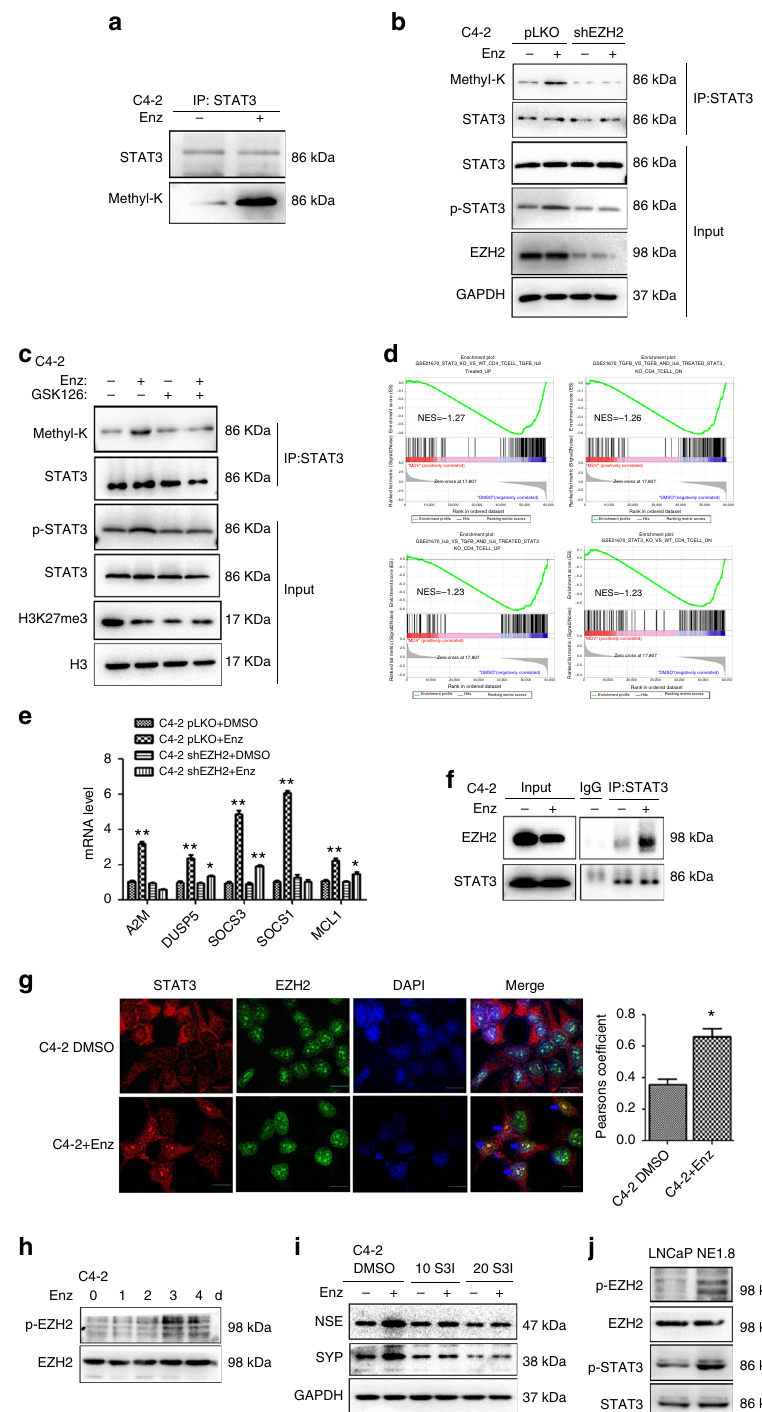
Fig. 4 EZH2 methylates STAT3 to promote NED after Enz treatment. a STAT3 methylation (Methyl-K) is increased in C4-2 cells treated with/without (w/o) 10 μ M Enz for 4 days and the lysine methylation of STAT3 detected by anti-lysine methylation antibody. b EZH2 knockdown can reduce Enz increased STAT3 methylation. C4-2 pLKO vector and shEZH2 cells were treated w/o Enz for 5 days, and then STAT3 methylation and phosphorylation detected by WB. c EZH2 inhibitor can reduce Enz-Increased STAT3 methylation. The levels of STAT3 methylation and phosphorylation w/o Enz and GSK126 treatment were detected by WB. d GSEA of STAT3 pathway enrichment in C4-2 cells with Enz treatment. e STAT3 downstream genes ’ expressions in C4-2 PLKO and shEZH2 cells after Enz treatment. f Co-IP assay to detect the interaction between EZH2 and STAT3 after Enz treatment. C4-2 cells were treated w/o Enz for 5 days. EZH2 antibody was used to pull-down the EZH2 complex, and the STAT3 level detected by WB. g Confocal microscopic images of co-localization of EZH2 and STAT3 after Enz or DMSO treatment for 4 days. The co-localization of STAT3 and EZH2 was analyzed by Pearsons coef fi cient (Scale bar = 2 μ m). Quantitation on the right. h WB analysis of EZH2 p-S21 in C4-2 cells w/o Enz treatment daily for 4 days. i STAT3 inhibitor, S3I-201 (S3I), can reduce the expression of Enz-induced NE markers. C4-2 cells were treated w/o Enz and S3I for 6 days, and the NE markers determined by WB. j The p-EZH2, EZH2, p-STAT3 and STAT3 levels in NE1.8 and LNCaP cells were analyzed by WB. For e , g , the data are presented as mean±SD, * p <0.05, ** p <0.005 by t- test NATURE COMMUNICATIONS| (2019) 10:2571